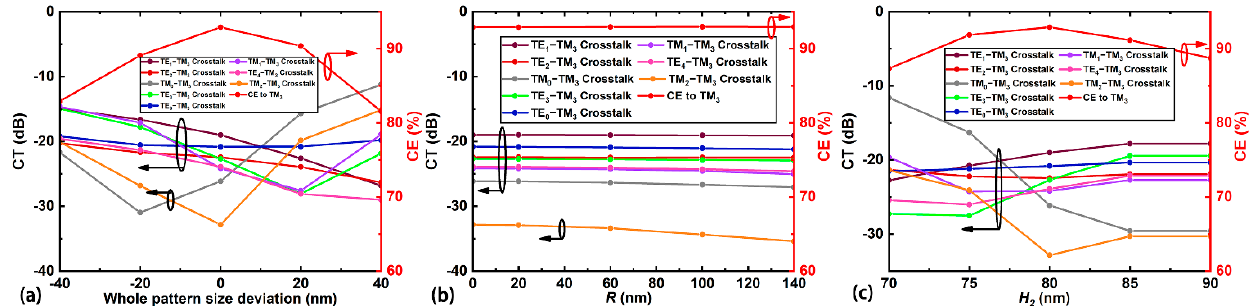
Figure 5. Fabrication tolerance analysis: ( a ) whole pattern size deviation, ( b ) curvature radius R of round corners of the shallowly etched rectangular slots, and ( c ) etching depth deviation H 2 , where the influences of such variations are reflected on the mode CE and CT of the proposed device.